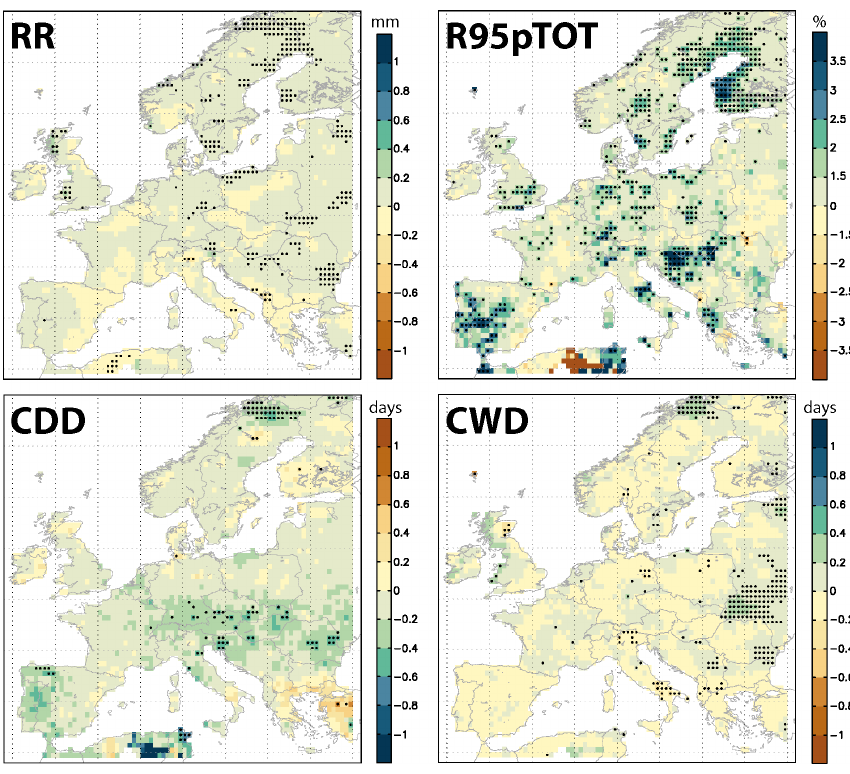
Fig. 9. As in Fig. 2, but for autumn. Table 5. As Table 2 for autumn. Only significant values are shown ( ∗∗ p value < 0.01, ∗ p value <